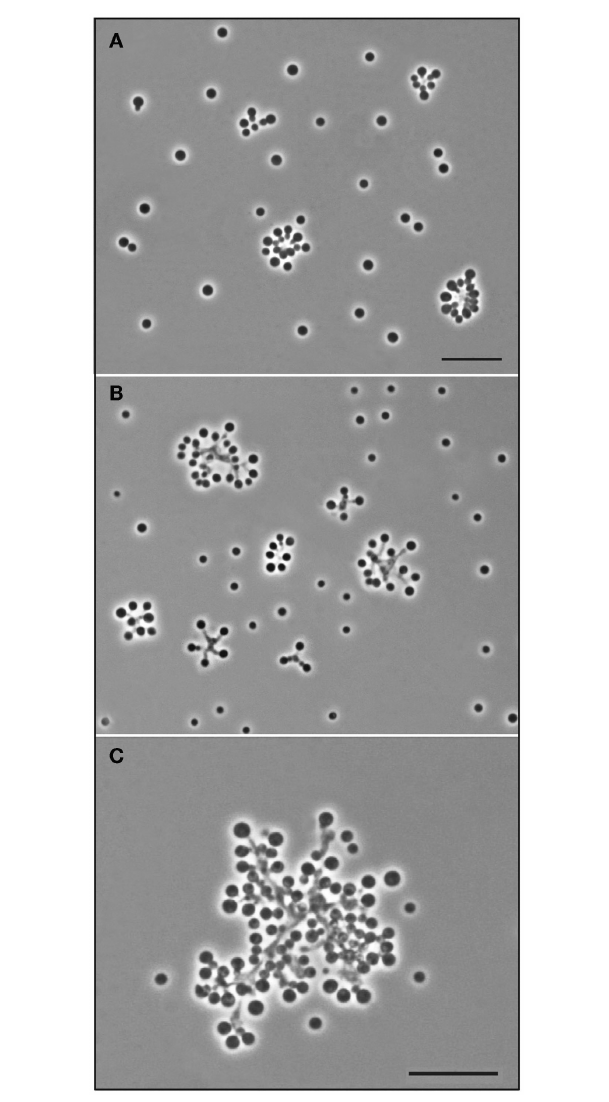
FIGURE 3 | Phase-contrast micrographs of cells and rosette-like cell clusters of strain SP2 T grown for 10days on solid medium M1N (A); cells of strain SP2 T (B); and OB3 (C) arranged in dendriform-like structures after growth on solid medium M1N for 1month; bar, 10 μ m.